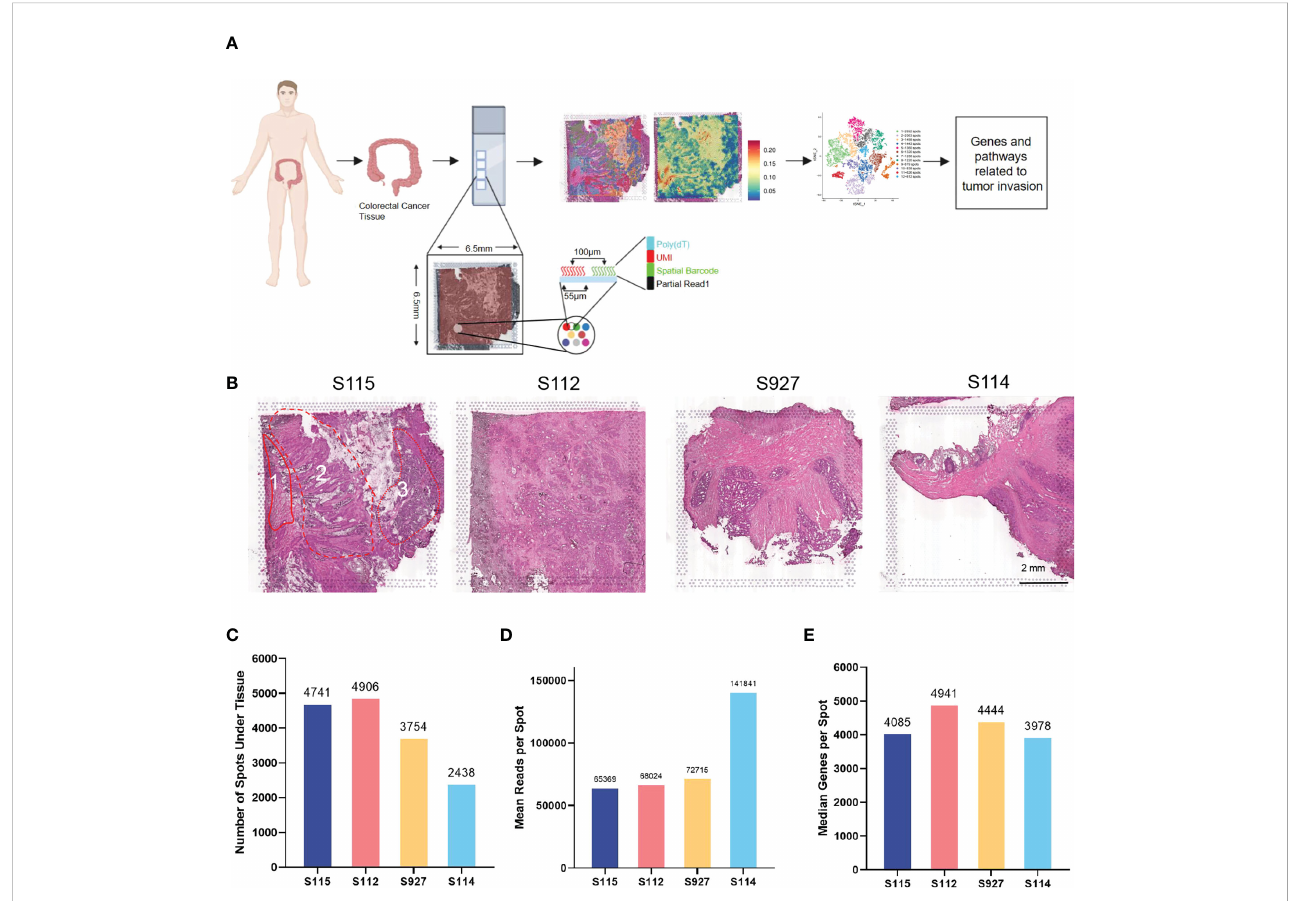
FIGURE 1 Outline of the CRC spatial transcriptomics data. (A) Work fl ow of spatial transcriptomics (ST) for CRC. CRC tissues from four patients (S115, S112, S927, S114) were used for ST by 10x Genomics Visium. (B) HE staining results of four samples. Sample 115 contained three parts: 1, invasive frontier; 2, cancer center area; 3, pre-cancerous area. The scar bar is 2mm. (C) The number of spots detected in the tissues of four samples. (D) The mean number of reads per spot in four samples. (E) The median number of genes detected in each